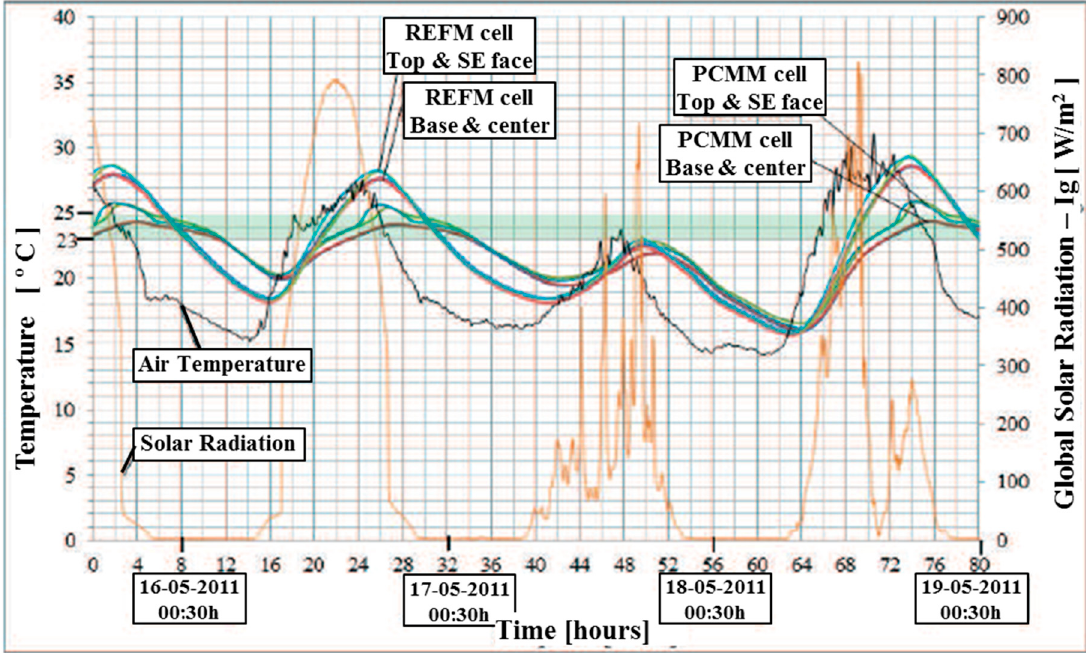
Figure 7. Experimental results of exterior temperature, global solar radiation and internal temperature of the test cell REFM (reference material) and test cell PCMM (PCM